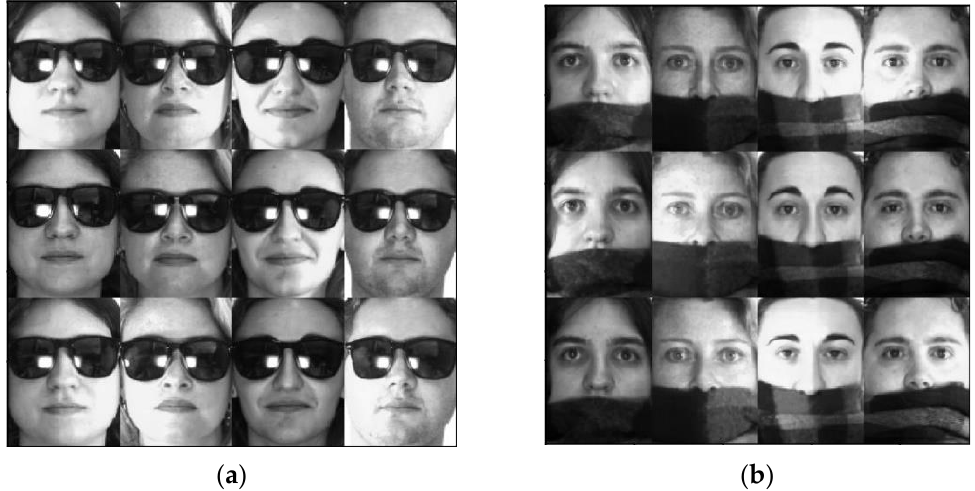
Figure 2. Faces from the AR subset occluded by sunglasses and scarves: ( a ) face images occluded by sunglasses; ( b ) face images occluded by scarves [ Reprinted with permission from Elsevier [20]. Copyright 2013, Neurocomputing. ] .